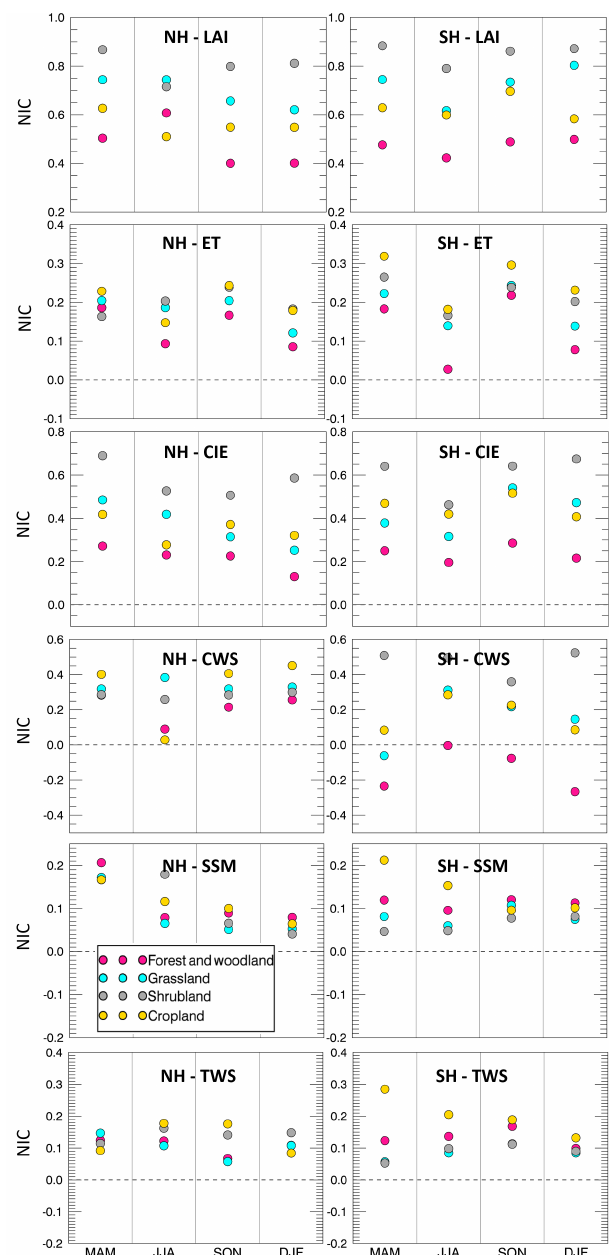
Figure 10. Same as in Fig. 9 but for the dry precipitation experi-